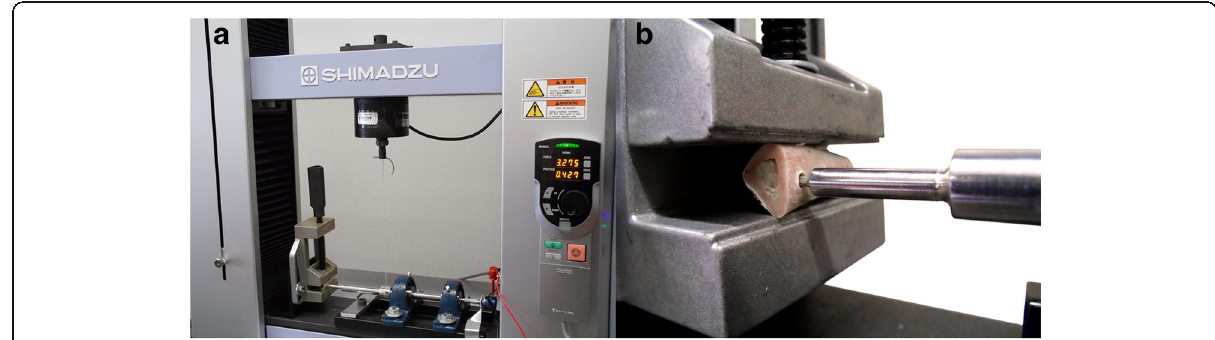
Fig. 2 Adaptation of Shimadzu universal testing machine for performing removal torque test of dental implants. a General view. b Assembly detail of connection between Allen keys socket and the implant placed in the